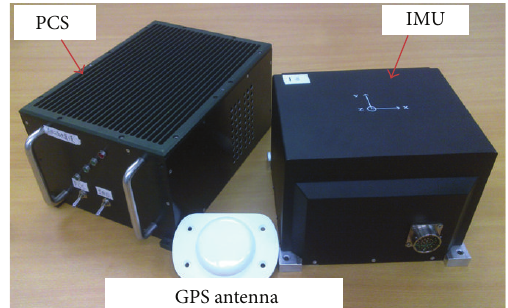
Figure 4: The hardware components of developed POS.